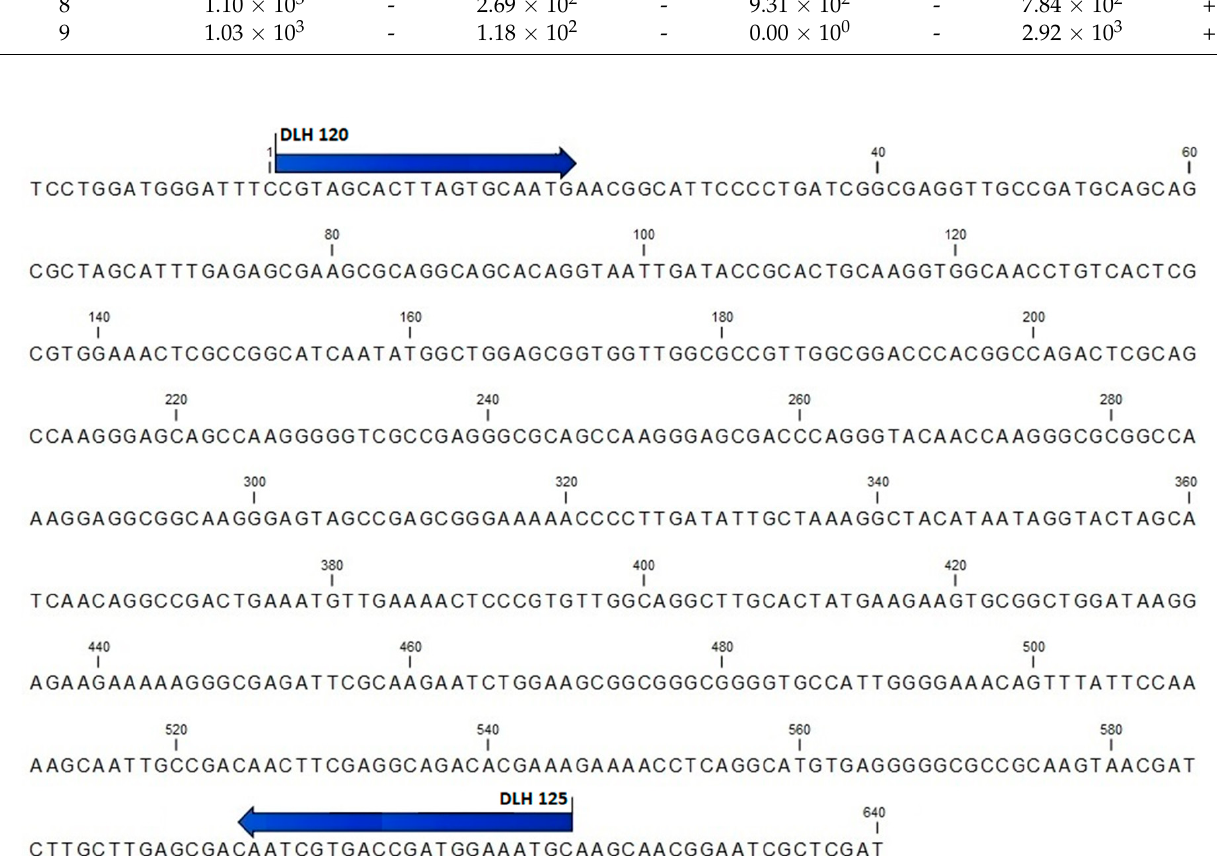
Figure A2. Amplification product of the conventional PCR with aligned hrpF primers [17].